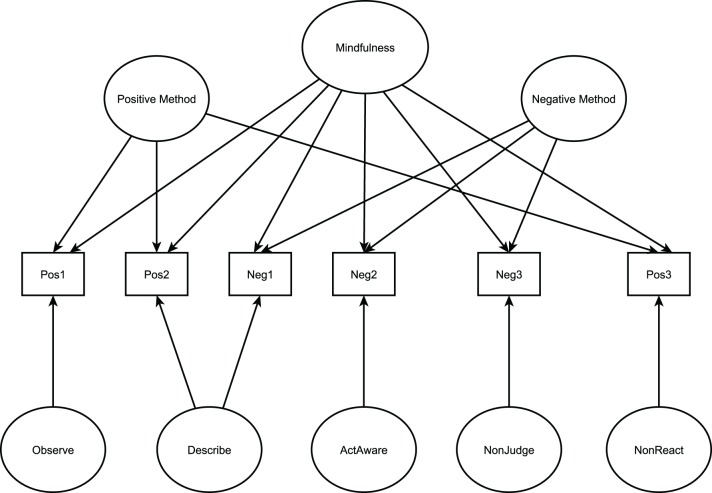
Model tested for the FFMQ: Bifactor model + uncorrelated negative and positive method factors. Individual items have been grouped for illustrative purposes. Analysis performed with individual items.